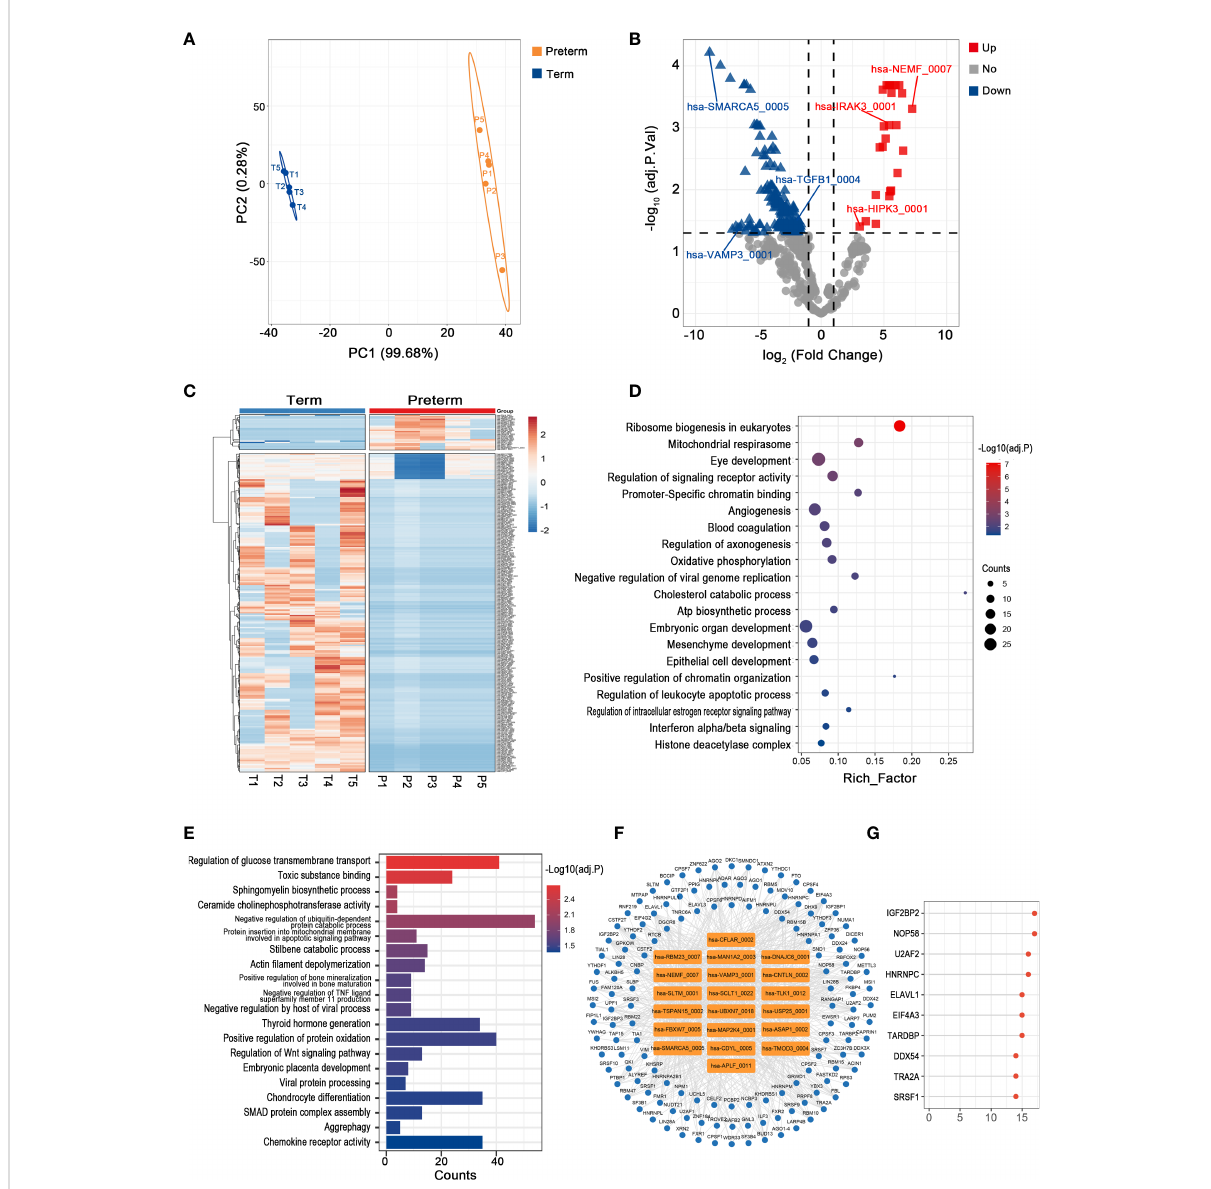
FIGURE 2 The circRNA changes and functional analyses in maternal plasma of PTB. (A) PLS-DA of circRNA expression in preterm (yellow points) and term (blue points) maternal plasma. (B) The volcano plot of circRNA changes and adj. p-values in maternal plasma of PTB. (C) The hierarchical clustering of DECs expression in term and preterm maternal plasma. (DECs: |log2 (fold change)|> 1 and adj. p-value < 0.05). (D, E) Functional enrichment analysis for co-expressed mRNAs (D) and target miRNAs (E) of DECs in preterm maternal plasma. (F, G) The DECs-RBPs network and the top 10 RBPs in maternal